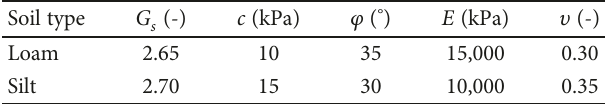
Table 2: Mechanical properties of soil (MnDOT Pavement Design Manual,